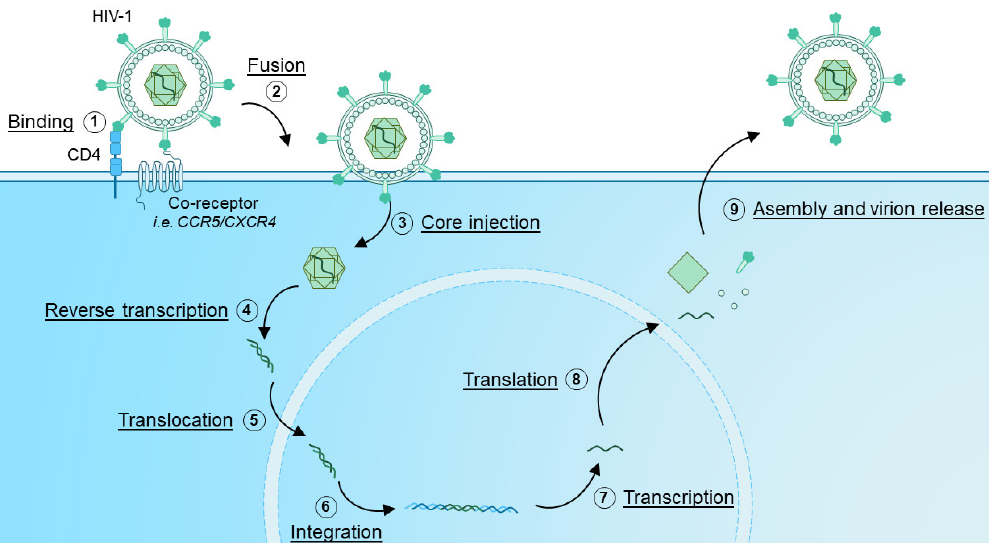
Figure 1. HIV infection and replication cycle. (1) HIV binds to target cells expressing CD4 via interaction with Envelope glycoproteins present on the virion. Co-receptors, such as CCR5 and CXCR4 are also engaged, which co-receptor is engaged is dependent on viral tropism. (2) By inserting the HIV Envelope glycoprotein into the membrane, the fusion of the virion and host cell membrane is enforced. Next, (3) the HIV viral core is injected, after which (4) the HIV viral genome is reverse transcribed and (5) translocated into the nucleus. (6) The HIV genome, now in DNA form, integrates into host DNA, where it can serve as a template for (7) transcription and (8) translation. The newly transcribed RNA and viral proteins are then (9) assembled into new virions which are released from the infected cell.